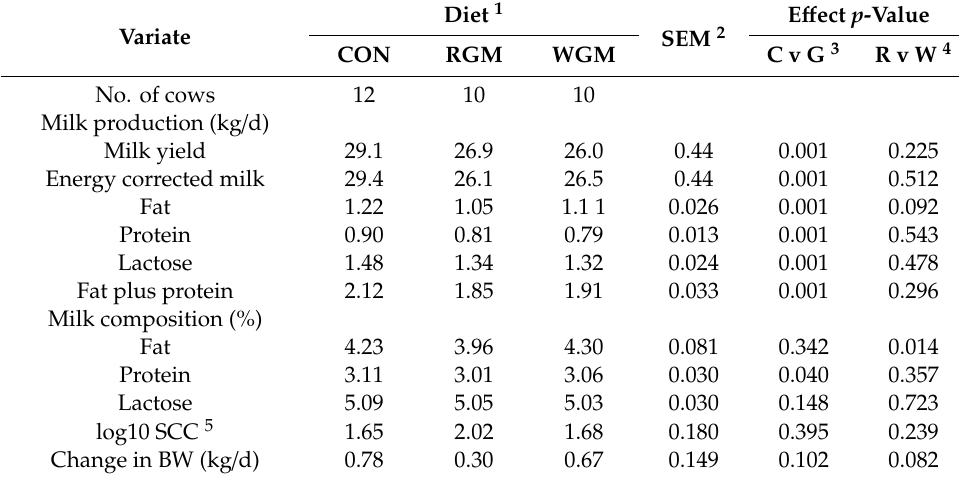
Table 5. Influence of diet on milk production, milk composition and change in body